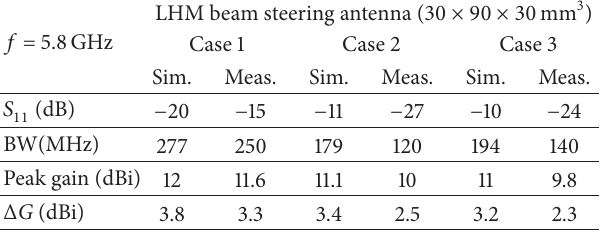
Table 4: Simulation and measurement results of LHM beam steering antenna. 𝑓 = 5.8 GHz